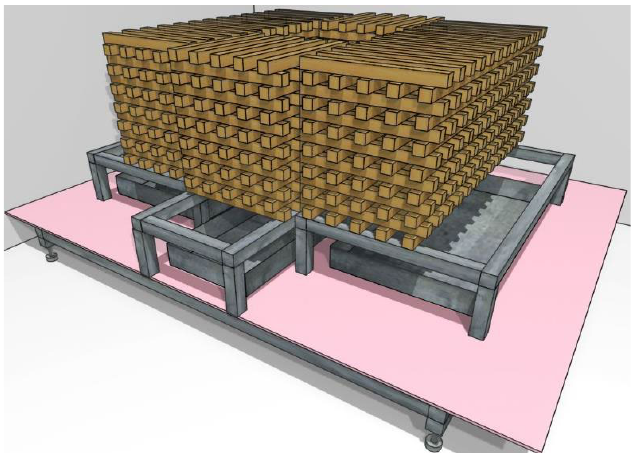
Figure 1. The 13A and 5A Woodpiles combination.